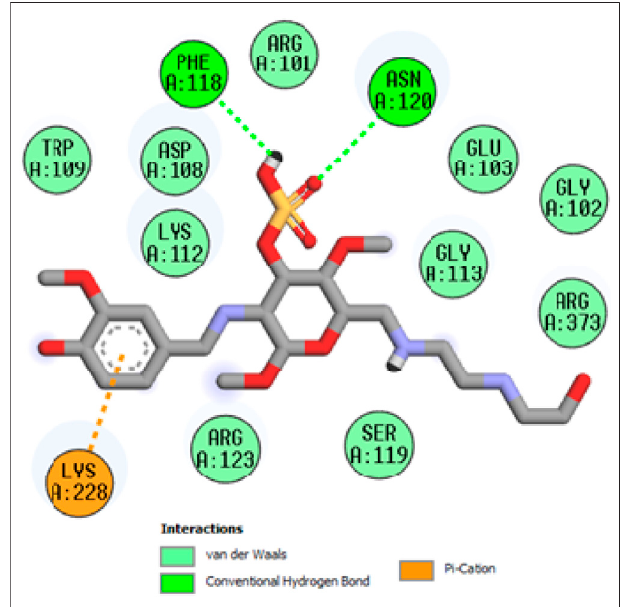
FIGURE 12 | Interaction of compound 2h in the binding pocket of 1Z11